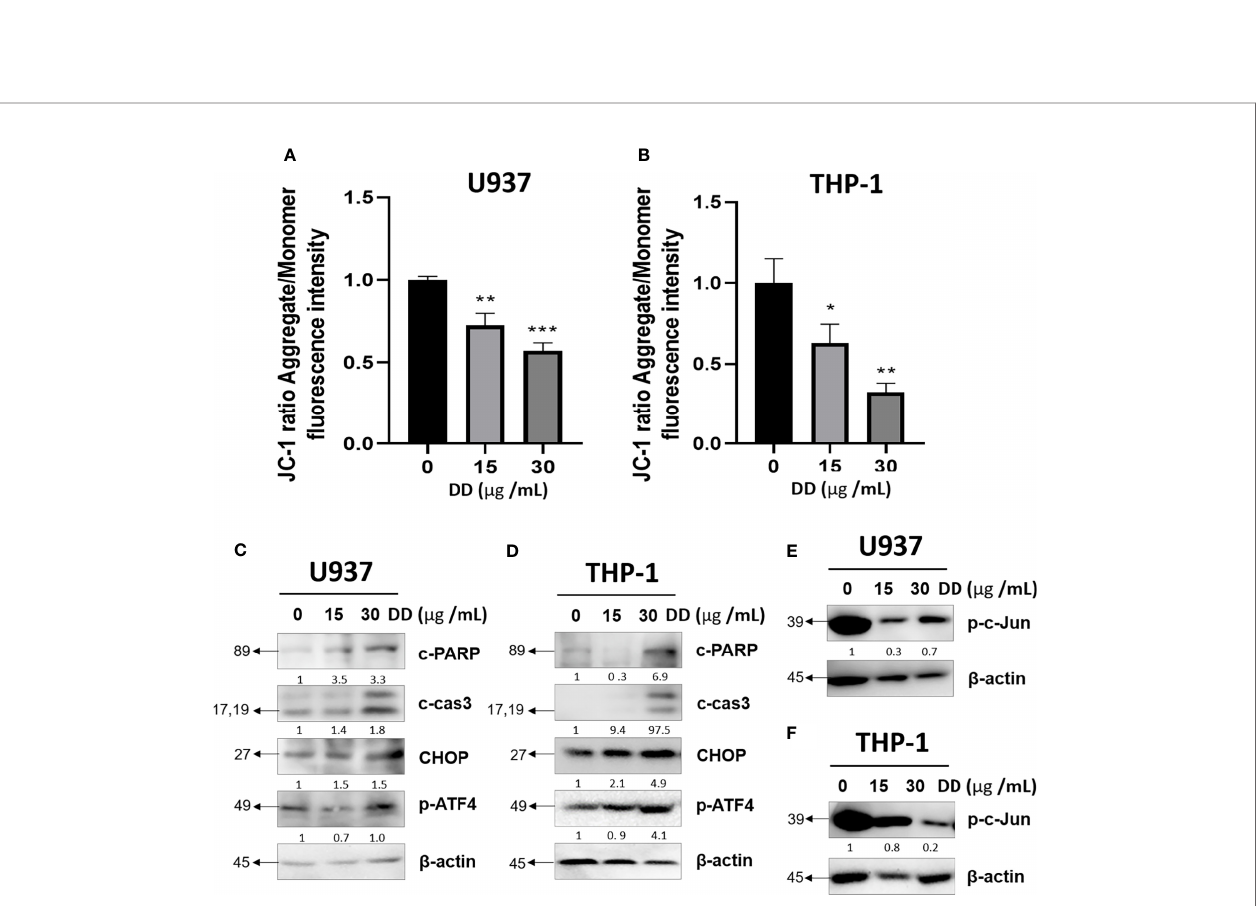
FIGURE 3 | Daemonorops draco Blume (DD) reduced mitochondrial membrane potential and induced apoptosis in U937 and THP-1 cells treated with DD. (A, B) Cells were pretreated at JC-1 (20 m M) and DD (15 and 30 m g/ml) for 4 h. Green monomeric fl uorescence form changed to red fl uorescent aggregates in a concentration- dependent manner, which was measured using a microplate reader. (C – F) After treatment with DD (15 and 30 m g/ml) for 24 h, the cells were subjected to Western blotting due to the expression of apoptosis-related proteins, such as cleaved caspase-3, cleaved poly(ADP-ribose)polymerase, CCAAT/enhancer-binding protein, p-ATF4, p-c-Jun, and b -actin, in (C, E) U937 and (D, F) THP-1 cells. Fluorescein isothiocyanate (excitation/emission = 540/570) and rhodamine (excitation/emission = 540/570). Values above represent the means of three experiments. Means ± standard deviation; * p < 0.05, ** p < 0.01, and *** p < 0.001 compared with the untreated